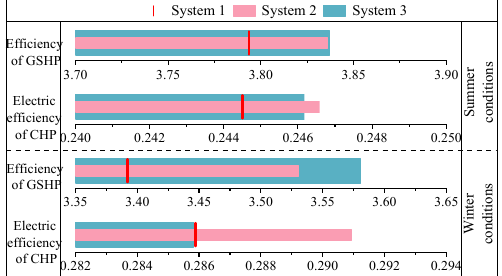
Figure 11. The average efficiency of GSHPs and CHP units under two operating conditions.